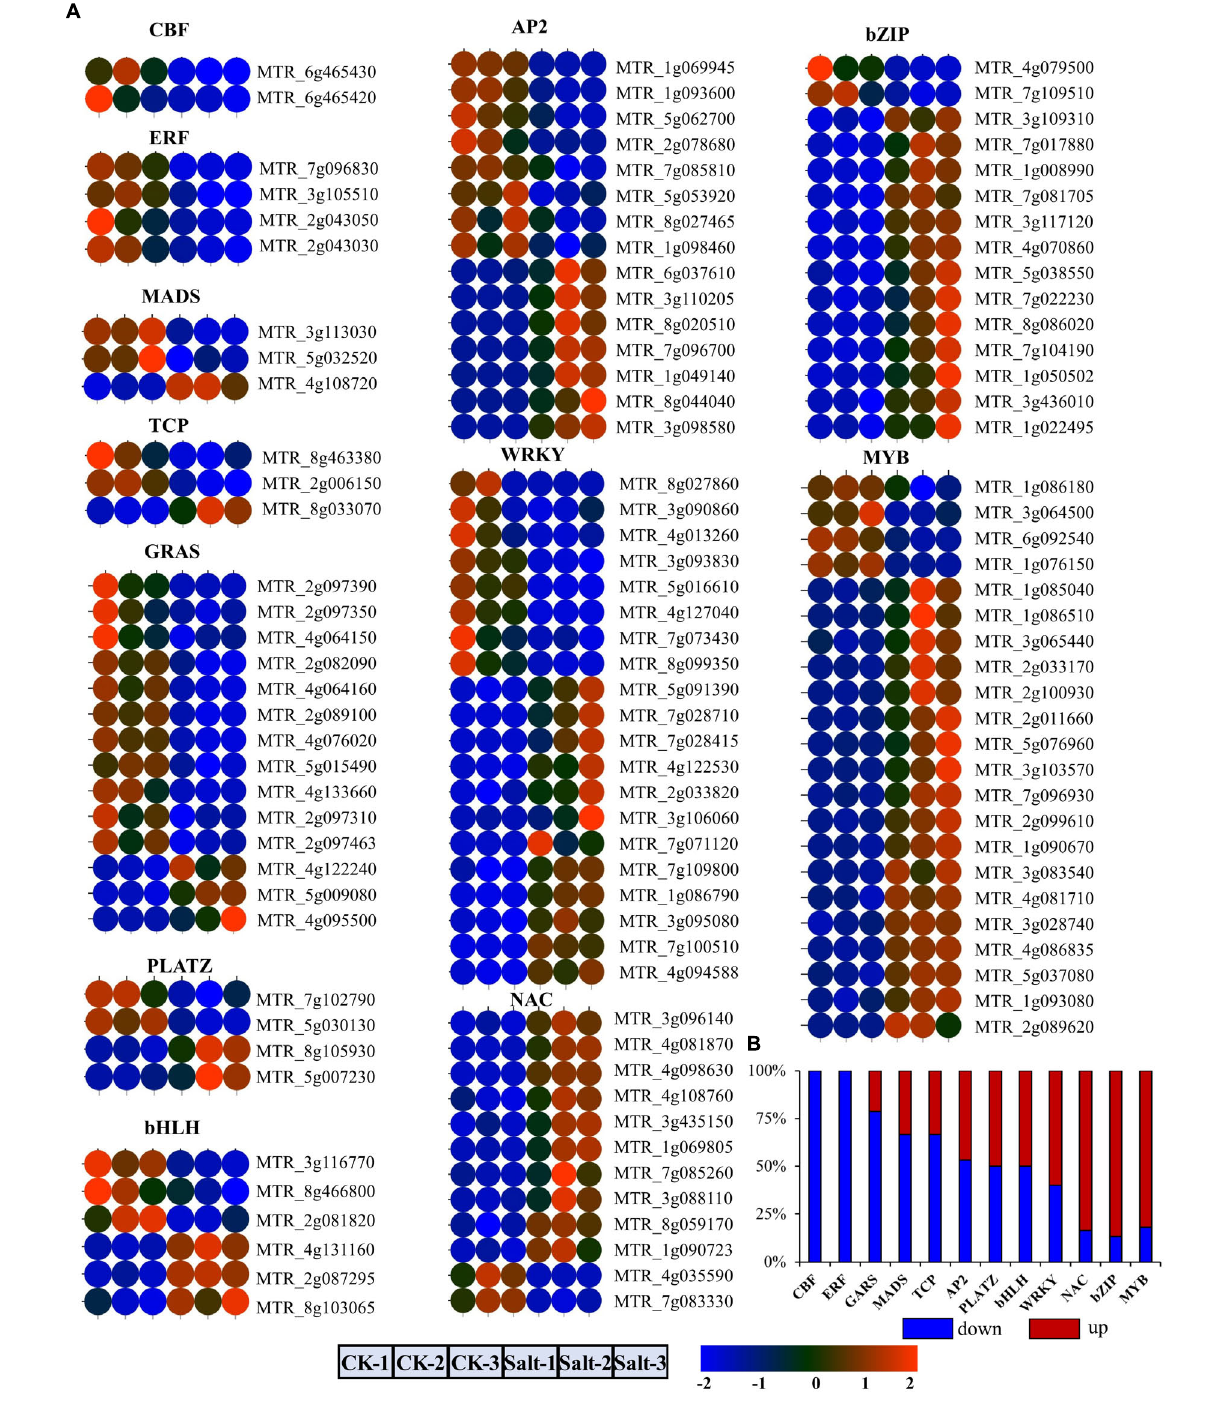
factor (CBF) and ethylene-responsive factor (ERF) TF families, including 2 and 4 differentially expressed TFs, respectively, were all down-regulated after salt stress ( Figure 2A ). Second, more